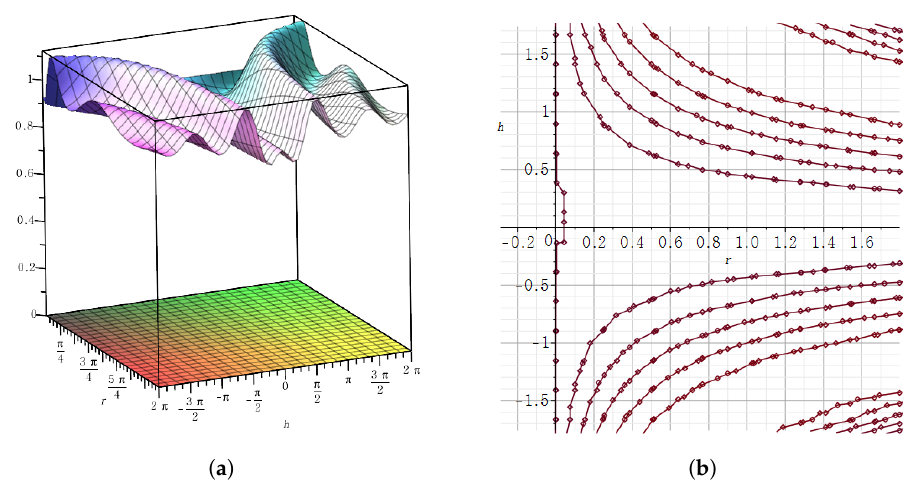
Figure 1. ( a ) Three-dimensional (3D) graph showing both zero and Err ( e z , z 0 ) . This indicates the relative error of e z at z 0 , when the step size h ( − 2 π ≤ h ≤ 2 π ) and direction magnitude r (0 ≤ r ≤ 2 π ) are changed independently of one another. ( b ) Contour line drawn on a plane to estimate the distribution and magnitude of the relative error according to h and r in the 3D graph of ( a ).